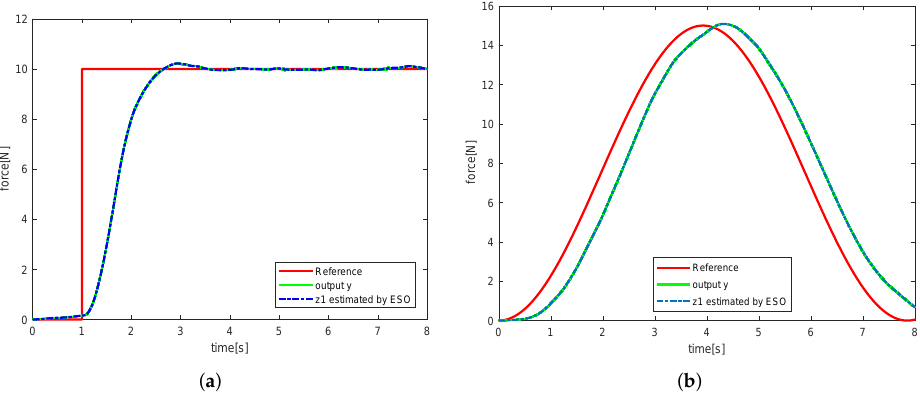
Figure 10. Simulation validation of the proposed control system. ( a ) Step response simulations. ( b ) Sinusoidal response